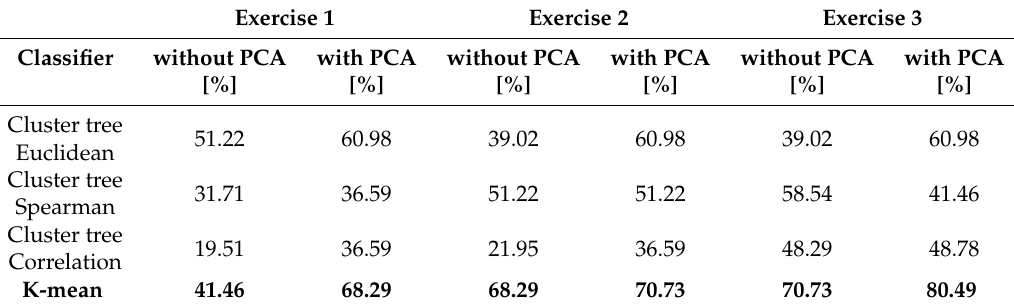
Table 4. Comparison of the effect of